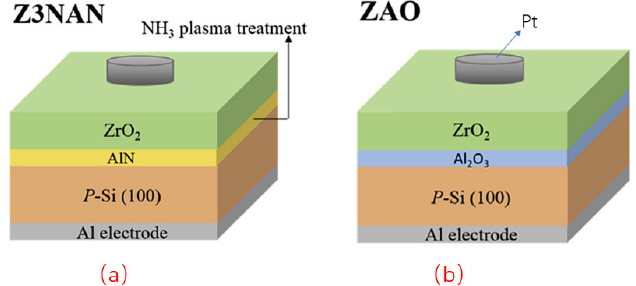
Figure 6. Schematic diagram of the ( a ) Z3NAN and ( b ) ZAO gate stacks [50]. Reprinted with permission from [50]; 2016 Elsevier.